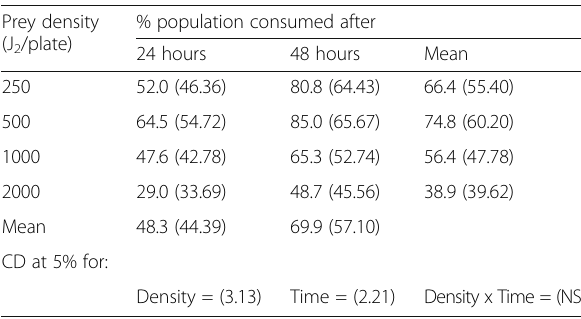
Table 1 Juveniles of Meloidogyne incognita consumed by Fictor